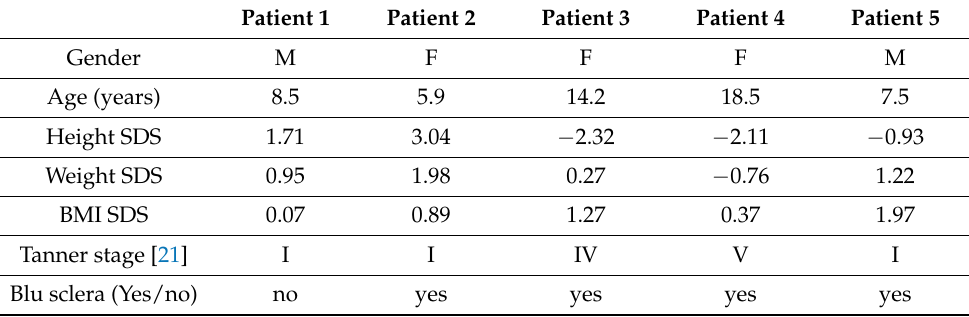
Table 1. Anthropometric, clinical, and quantitative ultrasound data of the study